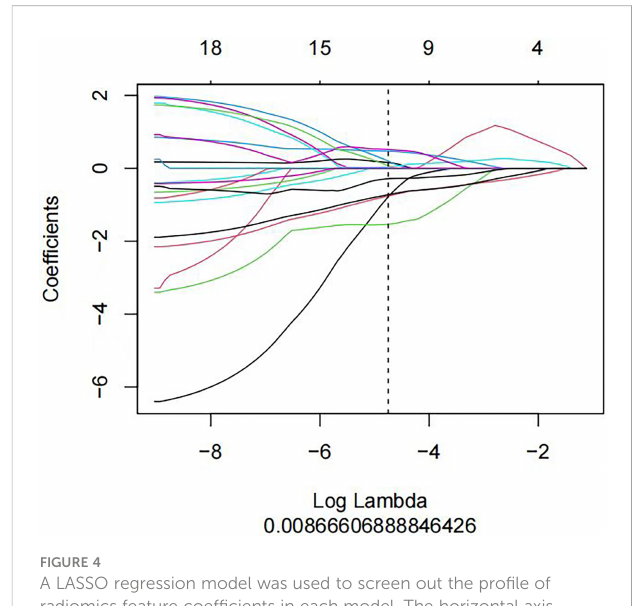
FIGURE 4 A LASSO regression model was used to screen out the pro fi le of radiomics feature coef fi cients in each model. The horizontal axis represents log( l ), and the vertical axis represents the selected characteristic coef fi cients. Each line represents the trend for each